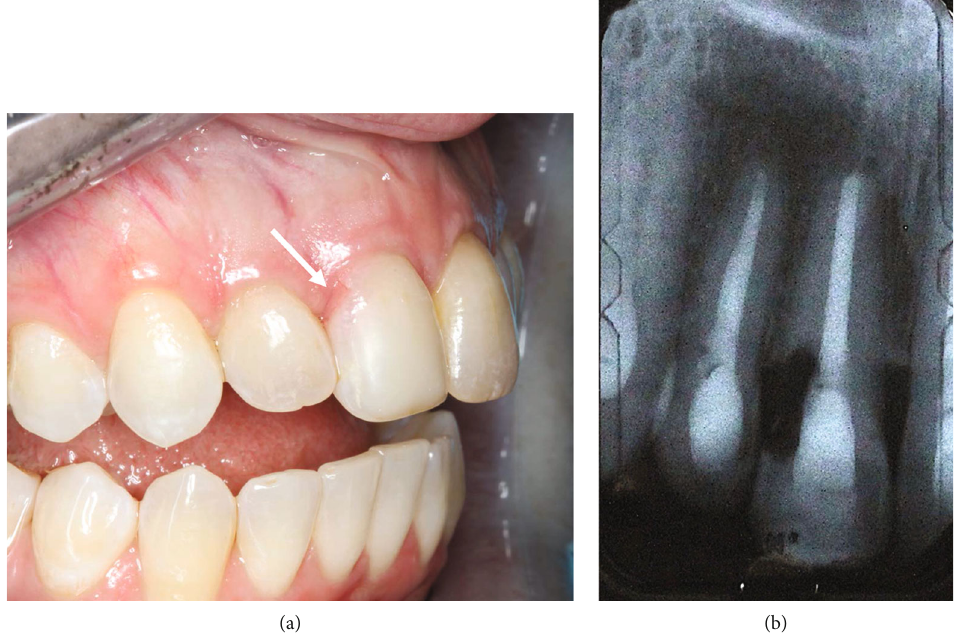
Figure 1: (a) Upper right central incisor with external root resorption (white arrow) was con fi rmed by (b) a periapical